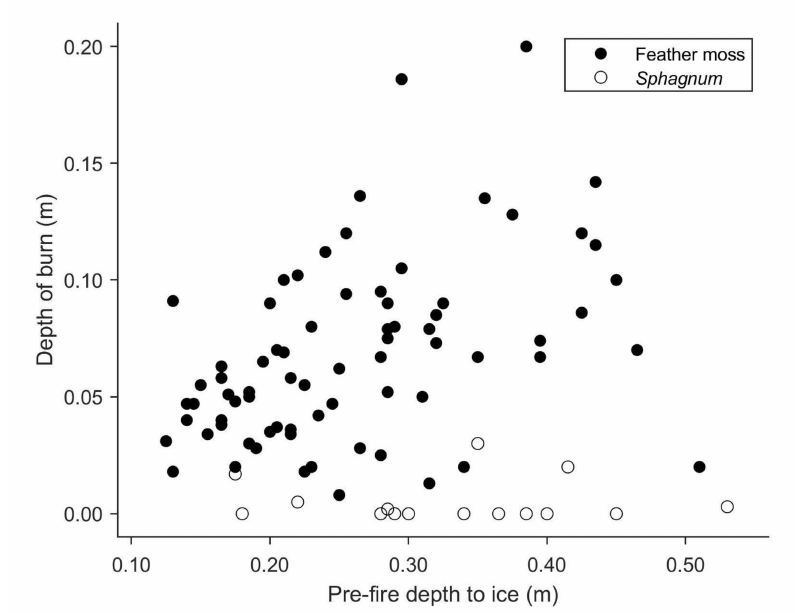
Figure 7. Manually measured moss depth of burn as a function of pre-fire depth to ice. Feather moss linear regression: DOB = 0.18 * depth to ice + 0.02; R 2 = 0.18. Sphagnum : DOB = − 0.003* depth to ice + 0.006; R 2 = 0.0012. Table 1. Fuel loading and fire behaviour characteristics between the control and the treated areas. The ratio of the treatment to the control is also shown. Control